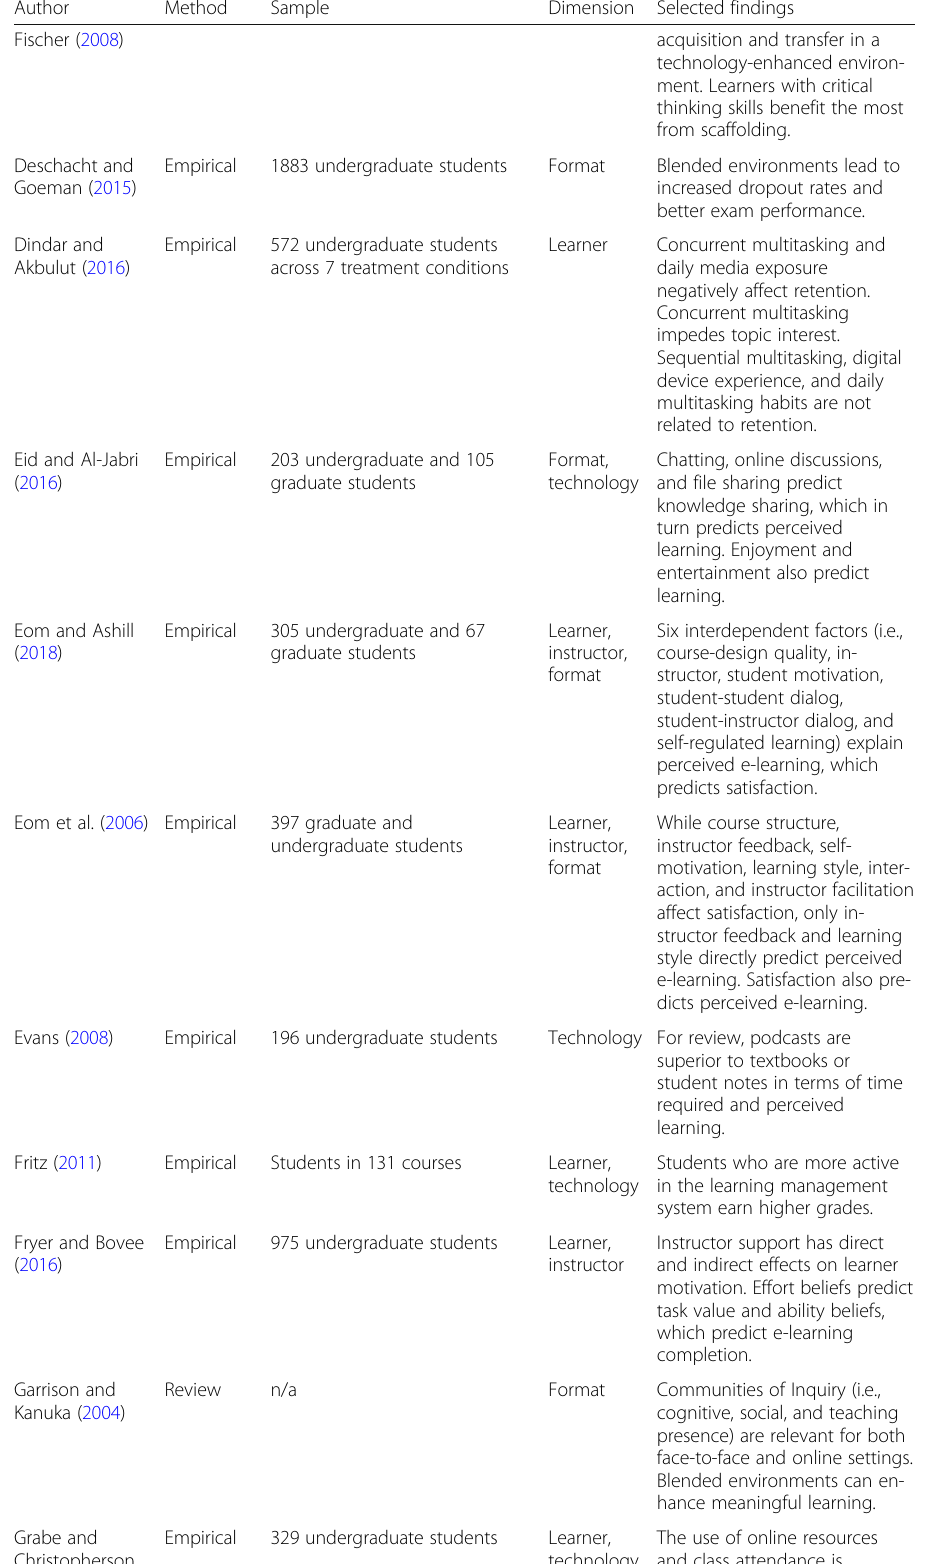
Table 1 Overview of Findings from the Extant Literature